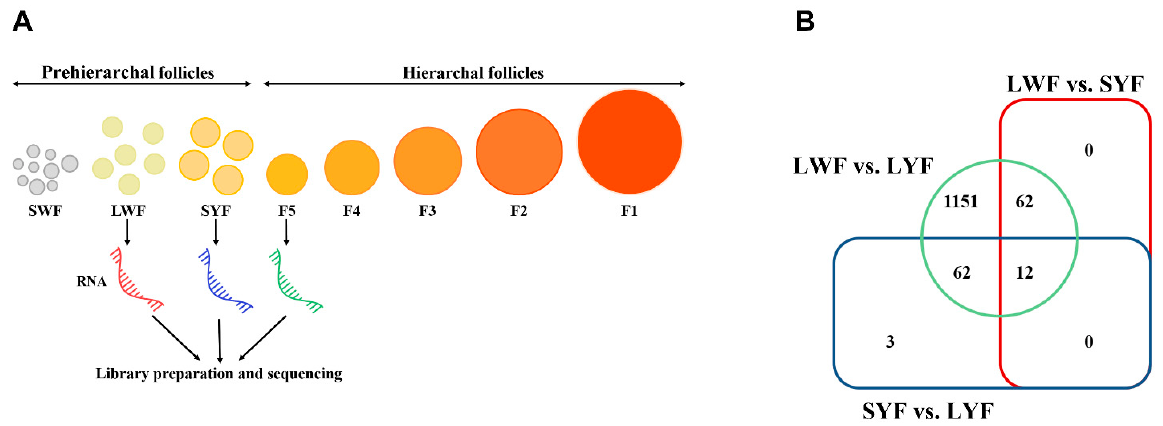
Figure 4. Experimental design of RNA-seq and differentially expressed gene (DEG) distribution. ( A ) Schematic illustration of the study workflow. Large white follicles (LWF), small yellow follicles (SYF), and large yellow follicles (F5/LYF) were collected for total RNA extraction and subjected to RNA-seq. ( B ) Venn diagram of DEGs; the criteria for filtering the DEGs were p_adj < 0.05 and |log (cid:2870) fold change| ≥ 1.